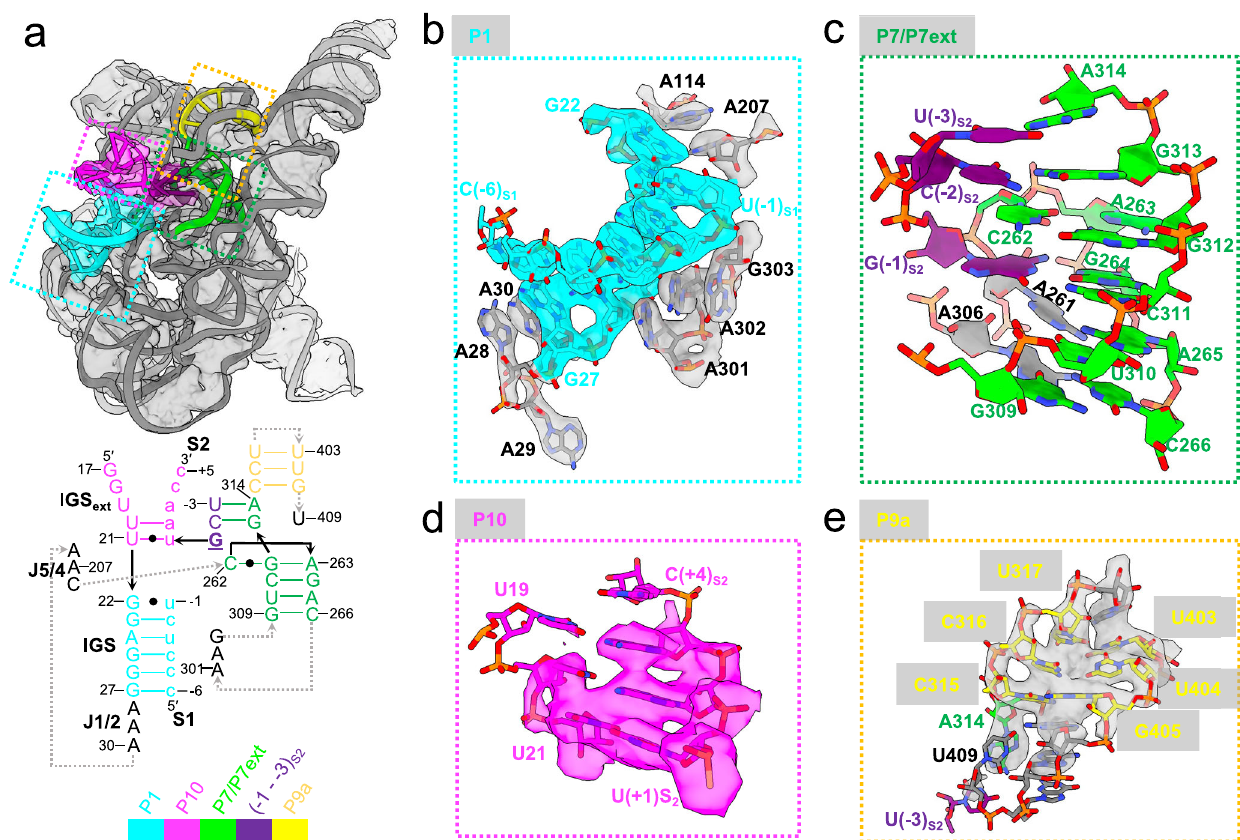
Fig.2|Structuralfeaturesof Tetrahymena L-16holoenzymeinCon1.a Cryo-EM map and model. The P1 helix, partial P10 helix, P7/P7ext, and P9a are highlighted, with their secondary structures shown below. Exon sequences are shown in low- ercaseandintronsequencesareshowninUPPERCASE. b Theintron ’ sIGS(G22-G27) interactswithS1(u[ − 1]-c[ − 6])toformthe6-bp